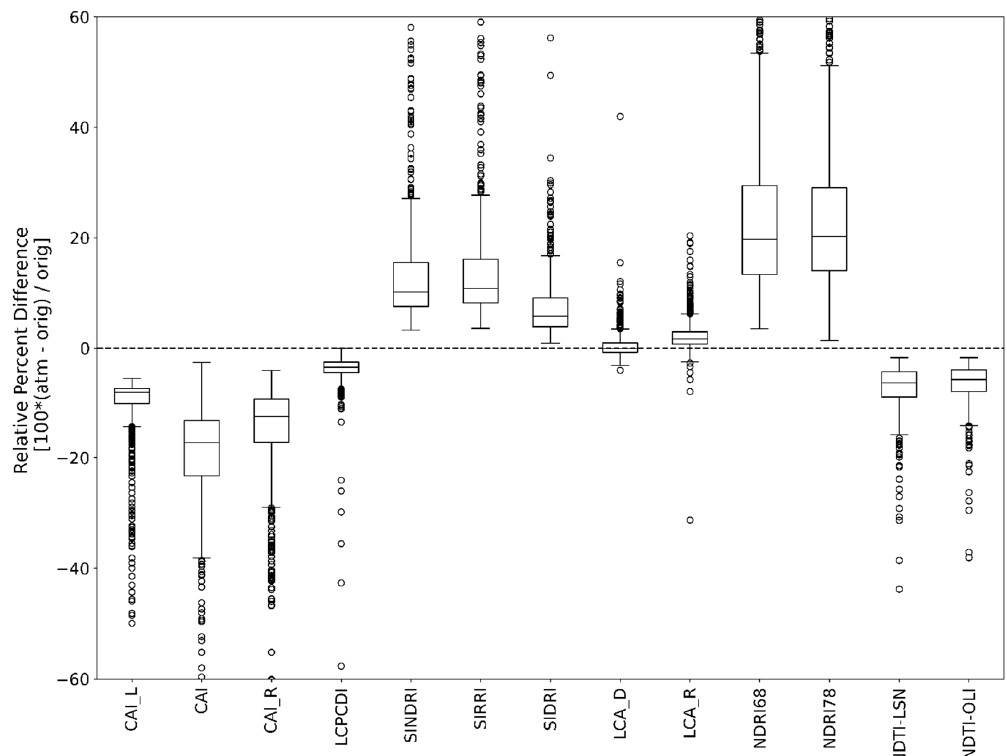
Figure 4. Relative impact of atmospheric residuals and sensor noise on SWIR NPV indices, computed using bandwidths with low RPD as shown in Figure 3 (2040: 10 nm, 2100: 10 nm, 2210: 30 nm, 2260: 30 nm, 2330 nm: 50 nm). See Table 1 for index definitions. The results in this figure are unique to a single atmospheric correction set of assumptions [43] and do not represent temporal or spatial atmospheric variability.